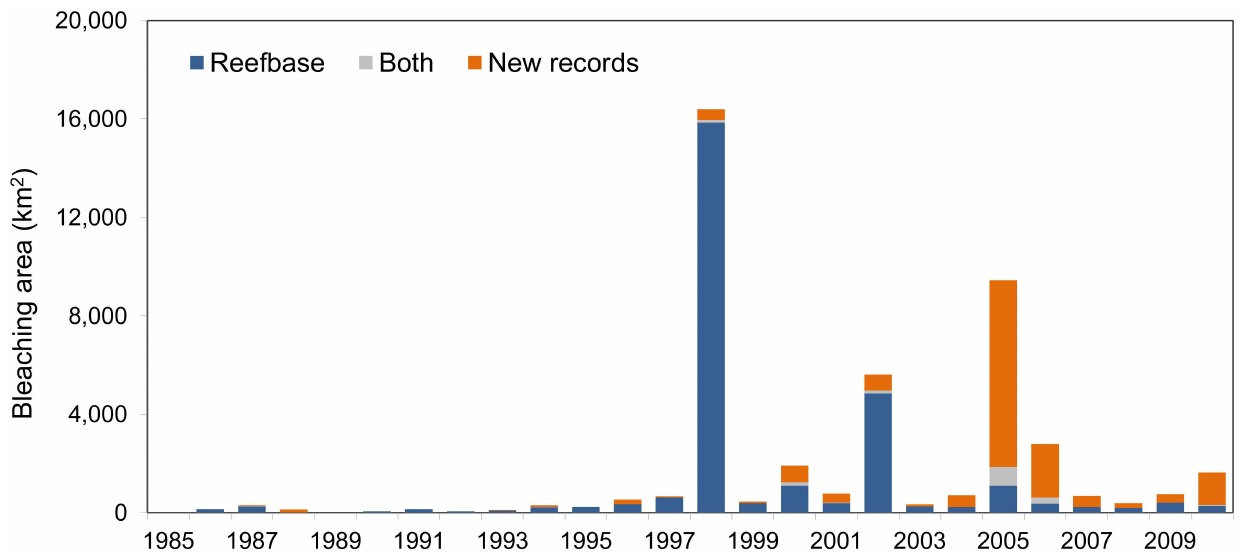
Fig 2. Annual area of moderate and severe(level 2 and 3) bleaching observations for 1985–2010. The area is computedfrom 0.04˚ × 0.04˚ latitude-longitude grid cells containing originalReefBase reports (navy blue), new records (orange),and those in both datasets (grey).